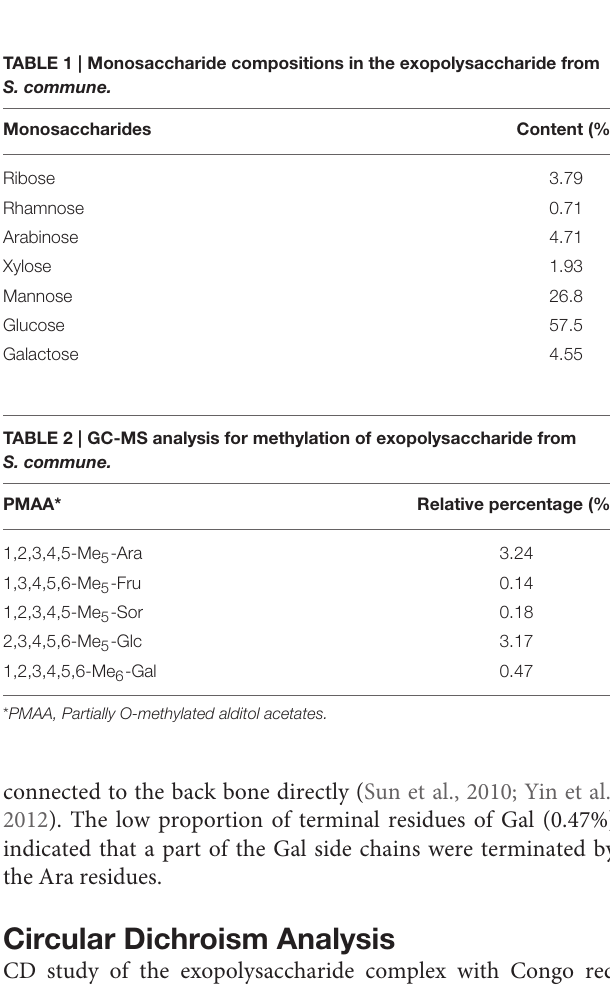
FIGURE 2 | GPC chromatogram of exopolysaccharide.